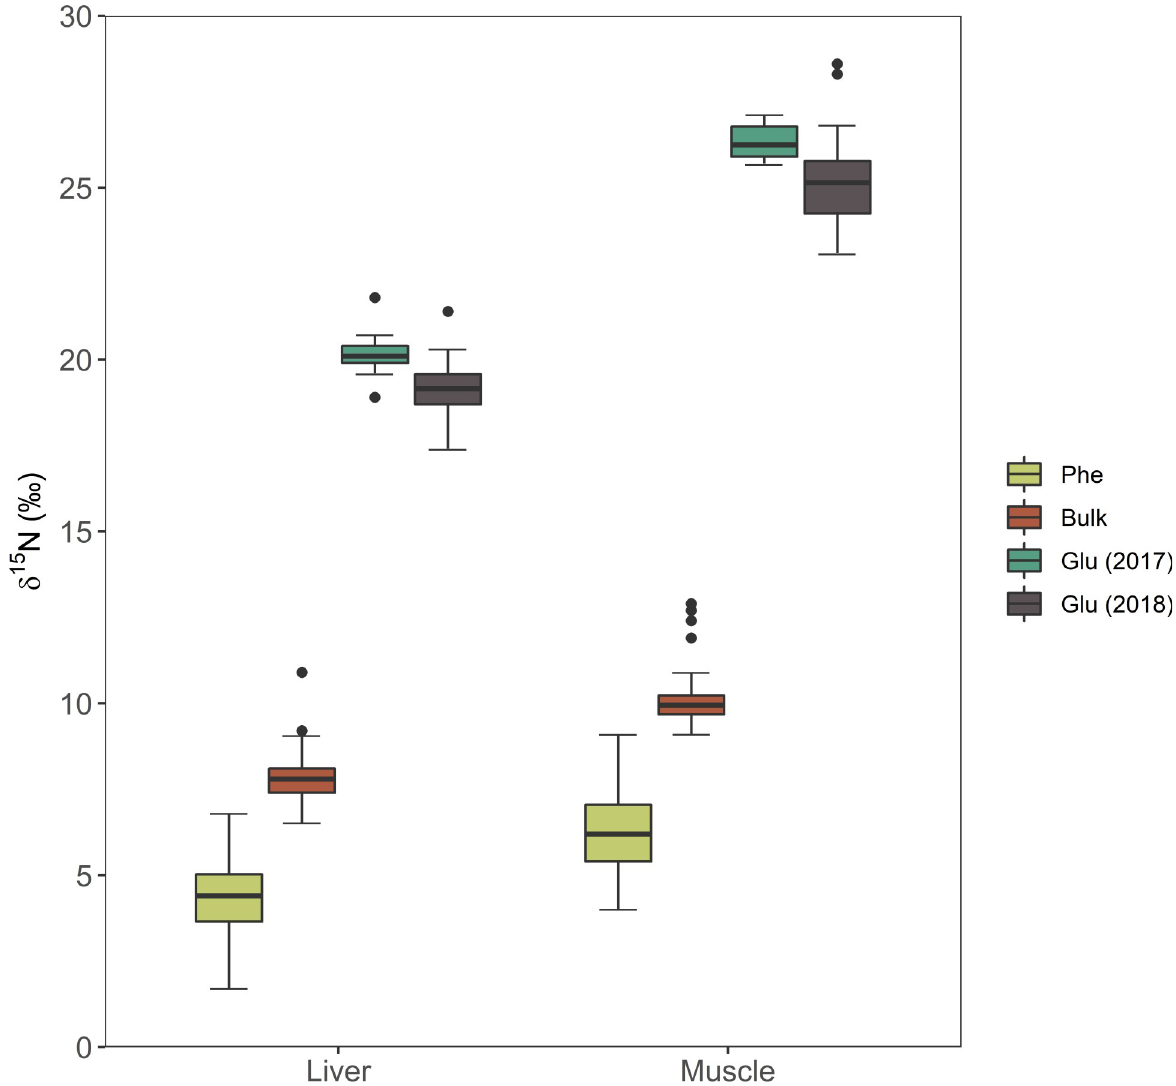
Fig 4. Comparison of δ 15 N of bulk tissues, phenylalanine and glutamic acid in liver and muscle tissues of YFT. Due to differences between δ 15 N values of glutamic acid, these were separated for analysis. Boxplots display the median (bold middle line), the interquartile range (box), and the minimum and maximum observations that extend to the whiskers and outlier points beyond the